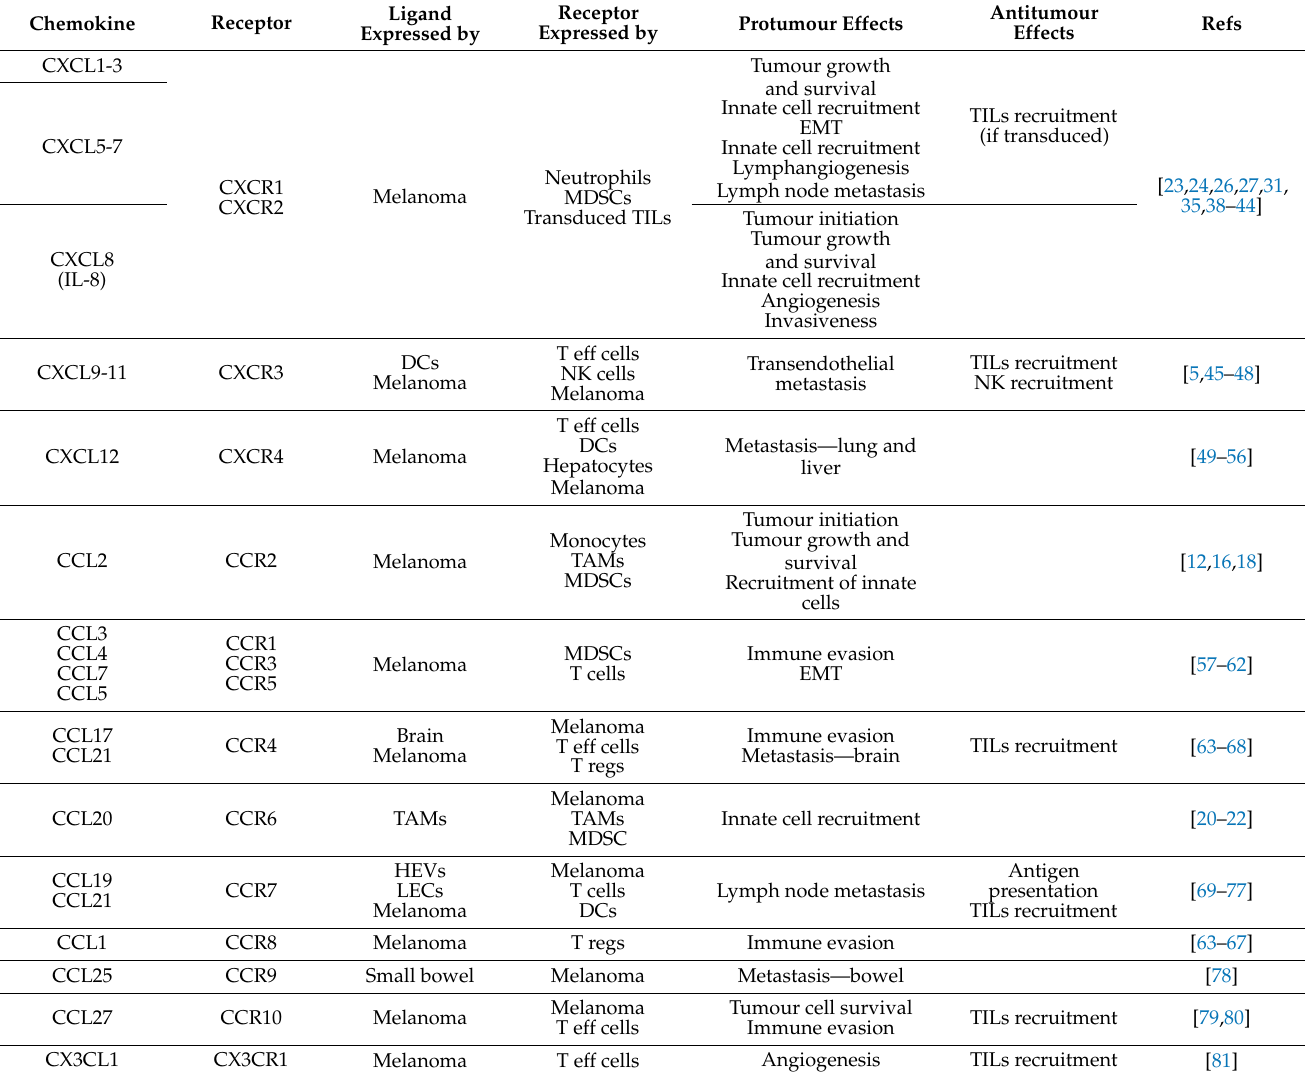
Table 1. Chemokines in melanoma: chemokines, their receptors, the cells on which they are expressed, and their pro- and antitumour functions in melanoma. Citations refer to preclinical studies that have determined the expression and role of chemokines and their receptors in a melanoma